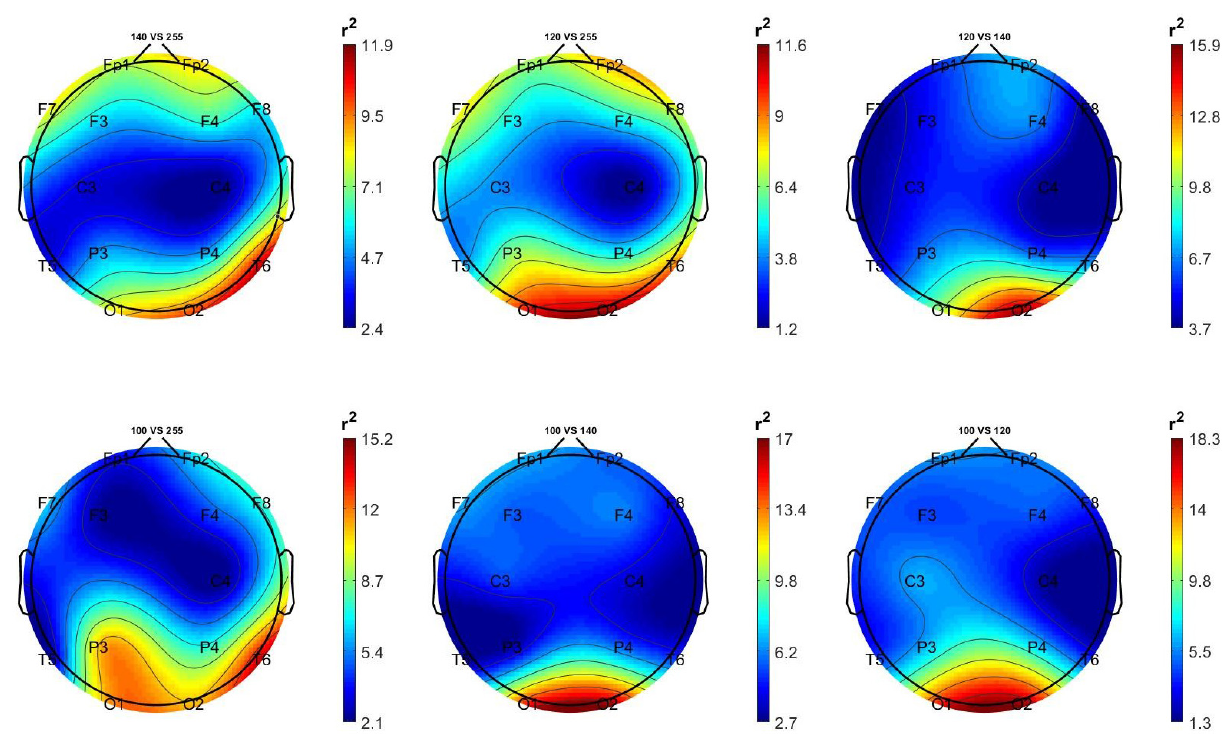
Figure 3. Topographic distribution of r 2 coefficients (stimulation vs non-stimulation discriminative power) of the stimulated participants. Top left: 14 Hz vs 0 Hz; top centre: 12 Hz vs 0 Hz; top right: 12 Hz vs 14 Hz; bottom left: 10 Hz vs 0 Hz; bottom centre: 10 Hz vs 14 Hz; bottom right; 10 Hz vs 12 Hz.